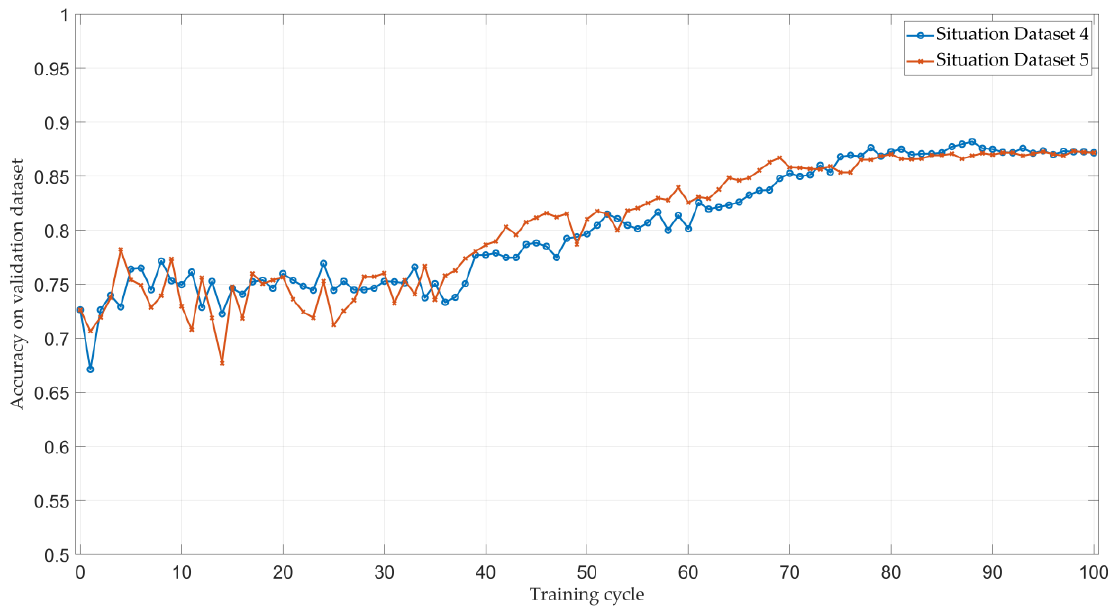
Figure 6. The average classification accuracy of the model at the end of each training cycle in the validation